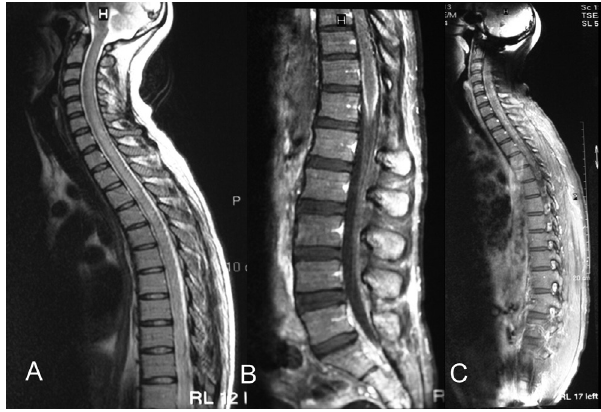
Figure 2 - Non-contrast T2-weighted image showing a diffuse high-signal intensity inside the cervical and thoracic spinal cord (a). Contrast sagittal T1-weighted image showing diffuse meningeal enhancement over the co- nus medullaris (b). The parenchyma was enhanced heterogeneously on the contrast T1-weighted image